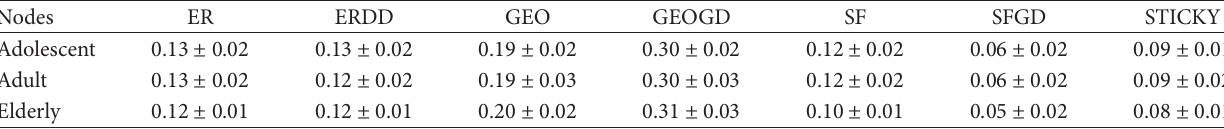
Table 4: Average shortest path length difference ratio in different groups.